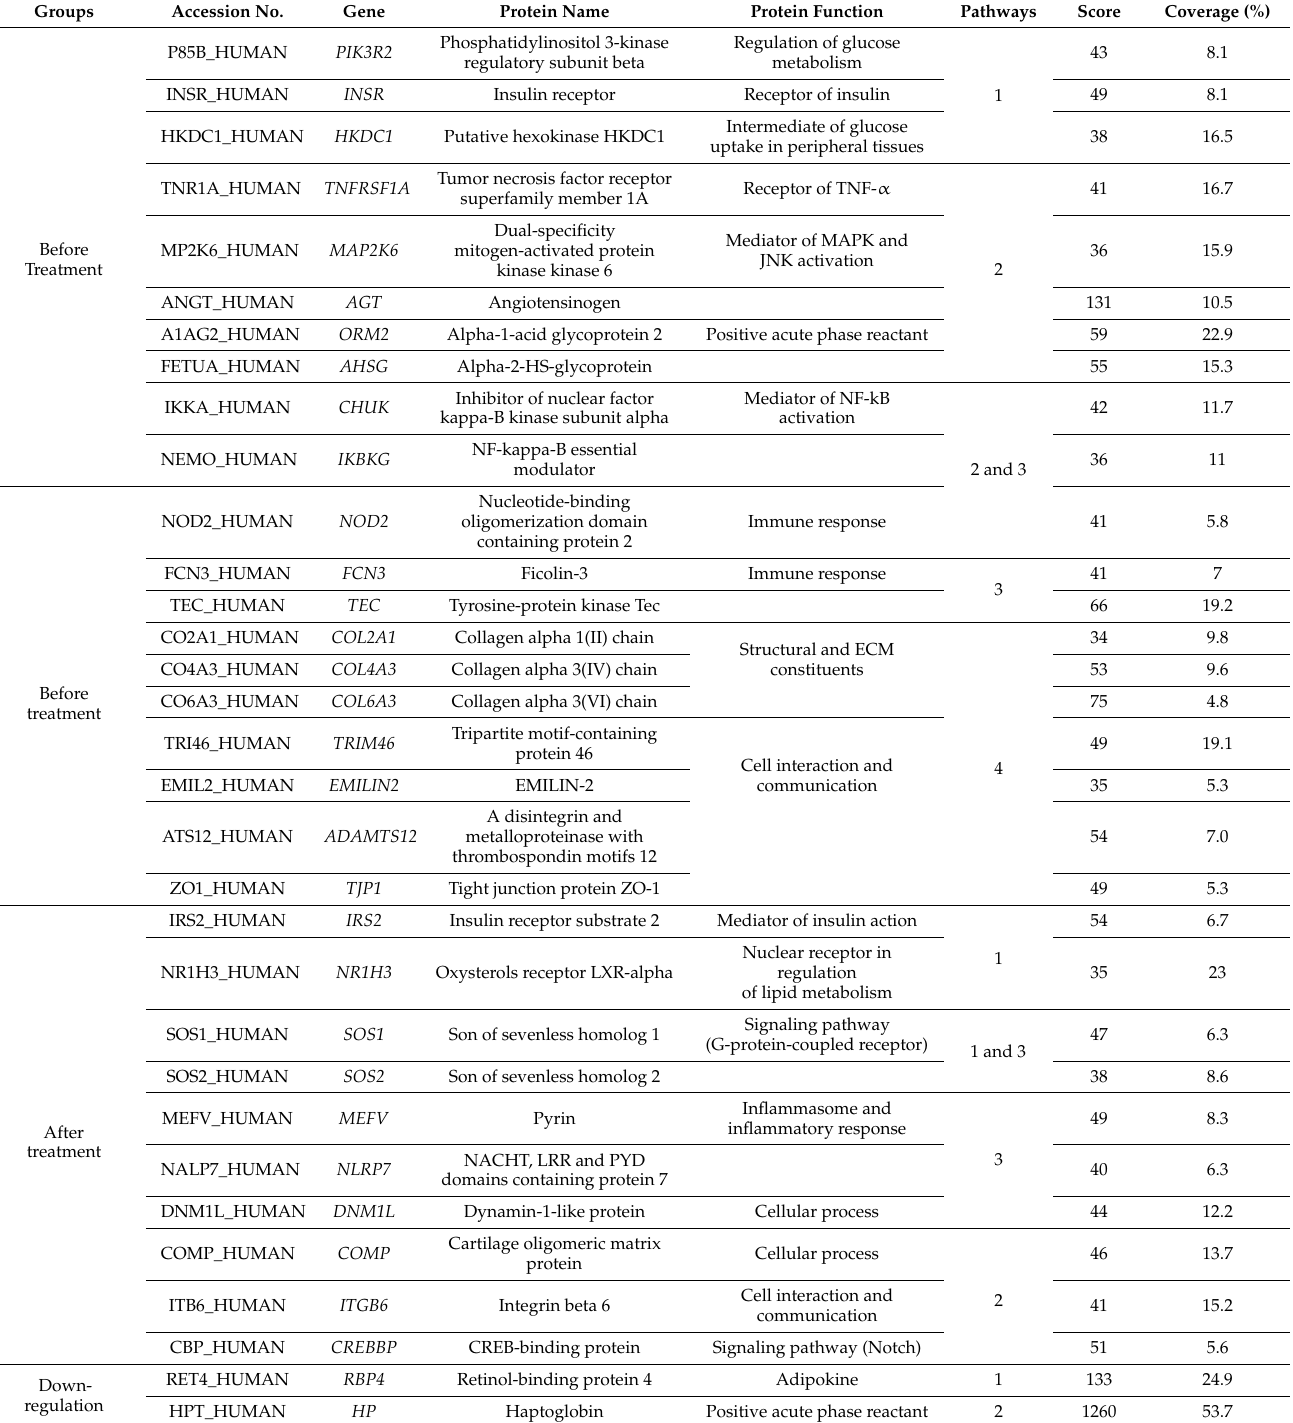
Table 3. The list of differential proteins associated with metabolic disturbance in type 2